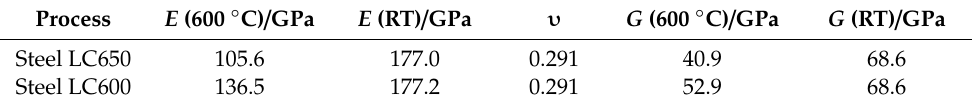
Table 4. The elastic modulus and shear modulus at room temperature and an elevated